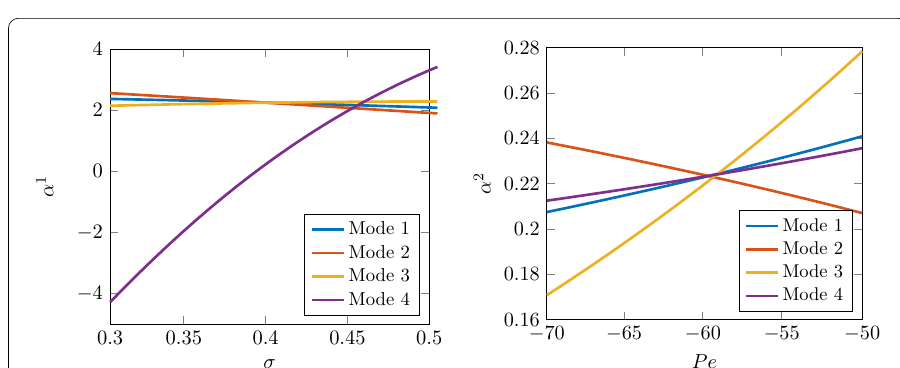
Fig. 4 First four spatial modes of the PGD solution